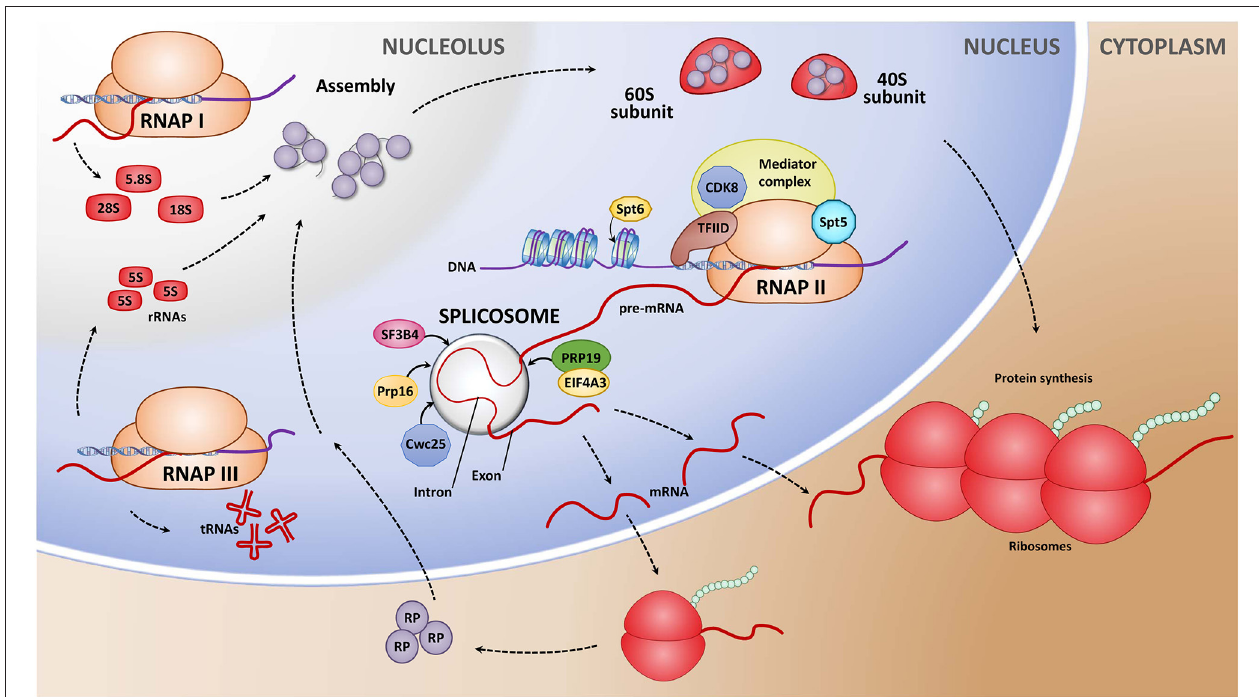
FIGURE 1 | Simplified representation of eukaryotic gene expression and post-transcriptional processing, highlighting the genes that were selected as potential RNAi targets. Gene transcription in eukaryotic cells is carried out by three multisubunit RNA polymerases. RNA polymerase I, II, and III (RNAPI, RNPII, and RNAPIII, respectively). RNAPI synthesizes the larger ribosomal RNA (rRNAs) precursor 28S, 18S, and 5.8S, whereas RNAPIII synthesizes 5S rRNAs, transfer RNAs (tRNAs), and small non-coding RNAs sRNAs (Wild and Cramer, 2012; Yokoyama, 2019). Processed rRNAs form the pre-40S and pre-60S ribosomal subunits, which